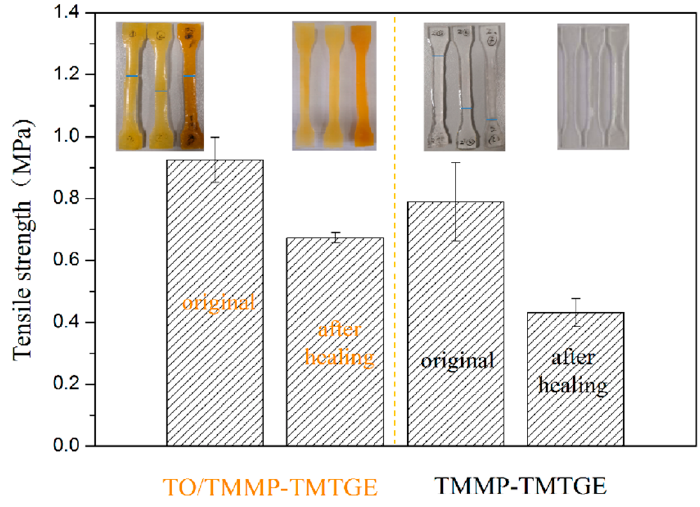
Figure 10. Tensile strengths of the TMMP-TMTGE self-healing material and TO/TMMP-TMTGE self-healing composite before and after healing.